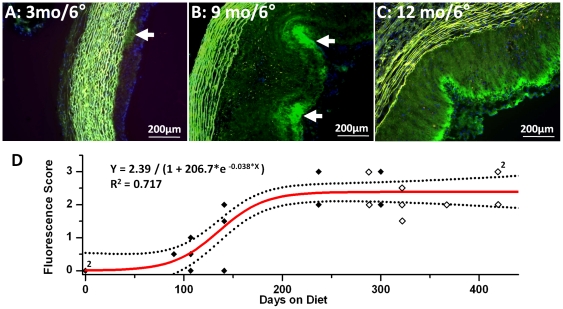
Duration of cholesterol feeding determines NP plaque penetration in vivo.A: 6 hours circulation in vivo with Alexa fluor-488 labeled NP in 3 month cholesterol diet rabbit aorta showing modest intimal plaque thickening and little fluorescent signal (arrow). Note lack of green-yellow autofluorescence in intima and + nuclear (DAPI stain). B: In vivo 6 hours circulation with identical NP in 9 month cholesterol diet rabbit aorta indicative of marked endothelial penetration and particle trapping (arrow). C: In vivo 6 hours circulation with identical NP in 12 month cholesterol diet rabbit aorta showing extensive NP penetration into intima (green). D: Sigmoidal fitting of fluorescence scores of aortas exposed in vivo to fluorescent NP circulating for 2 hours (open) and 6 hours (solid) on rabbits fed with cholesterol for 0 to 419 days. The temporal dependence of plaque permeability on the duration of hypercholesterolemia is well approximated with a sigmoidal function.